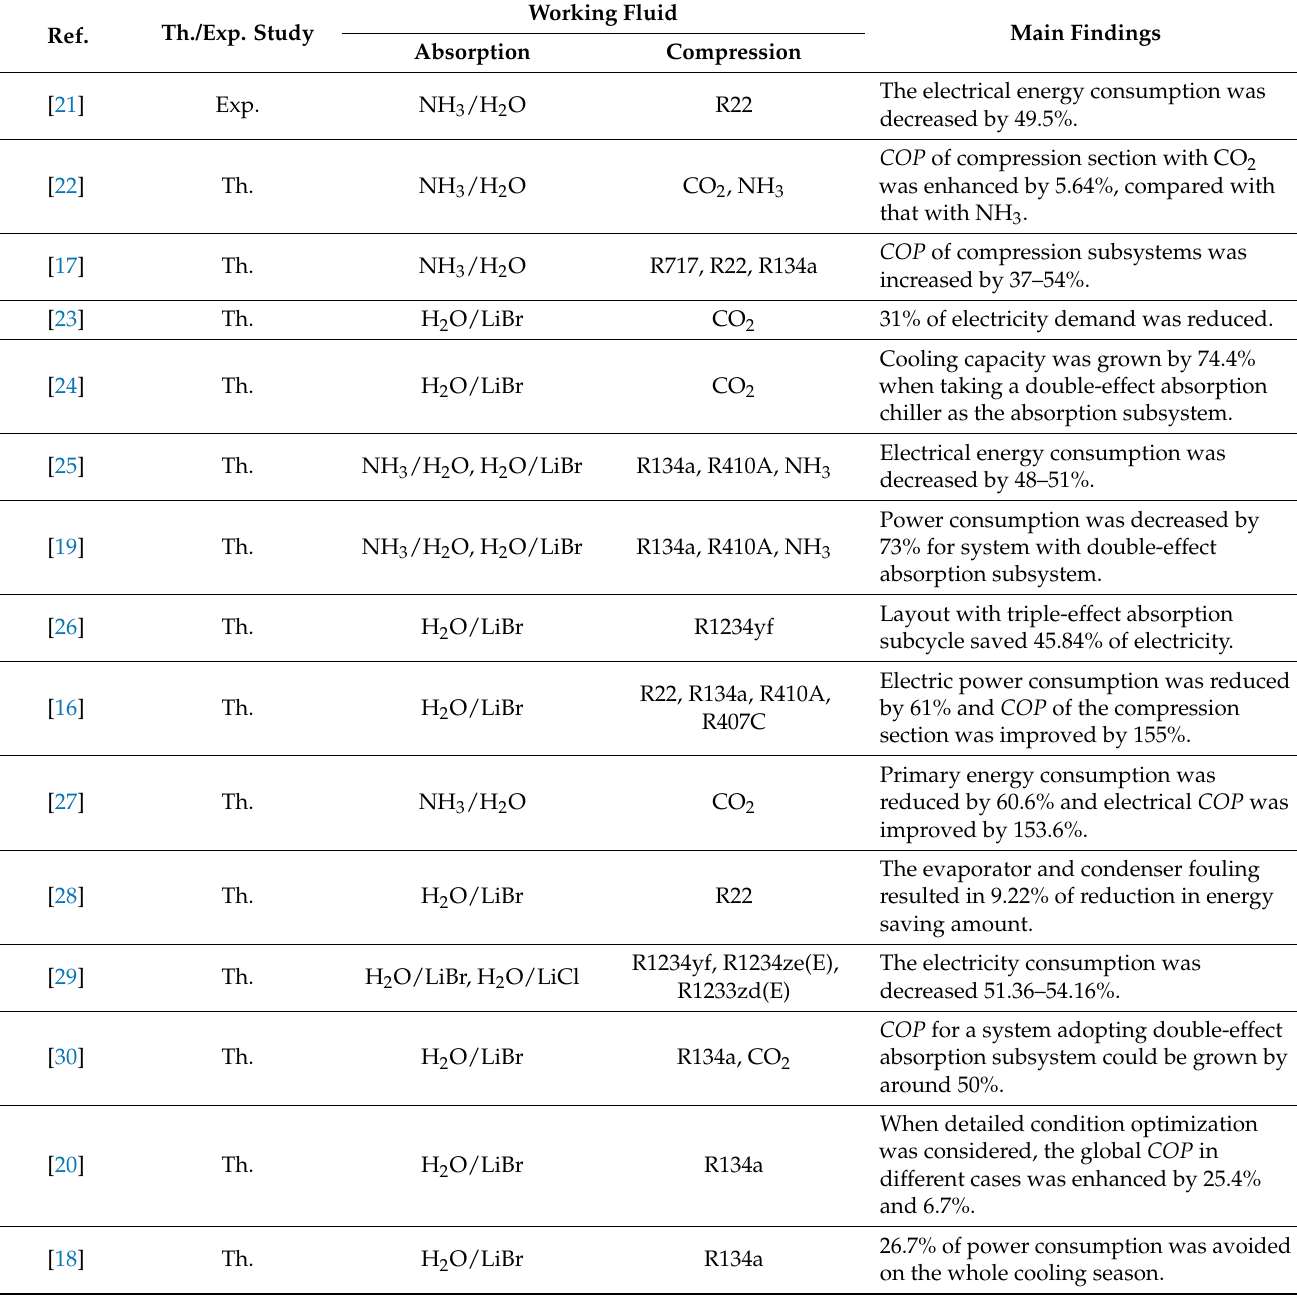
Table 2. Summary of literature survey on layout with a cascade condensation